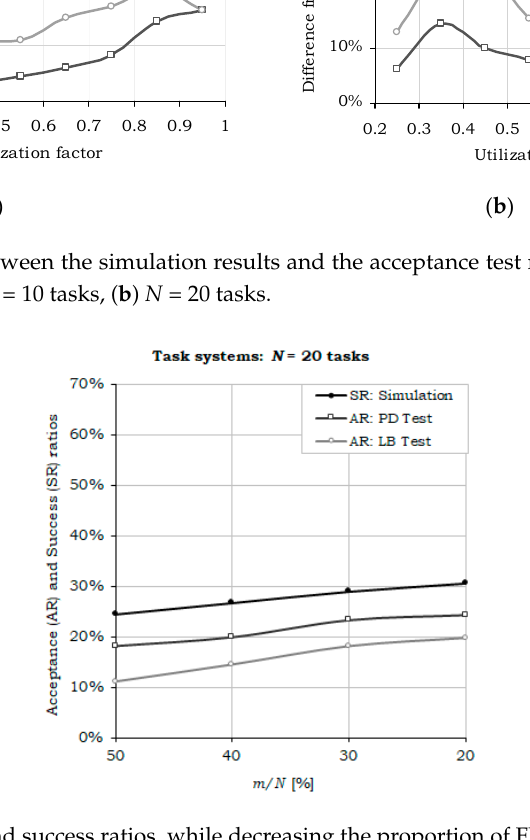
Sensors 2017 , 17 , 1504 15 of 21